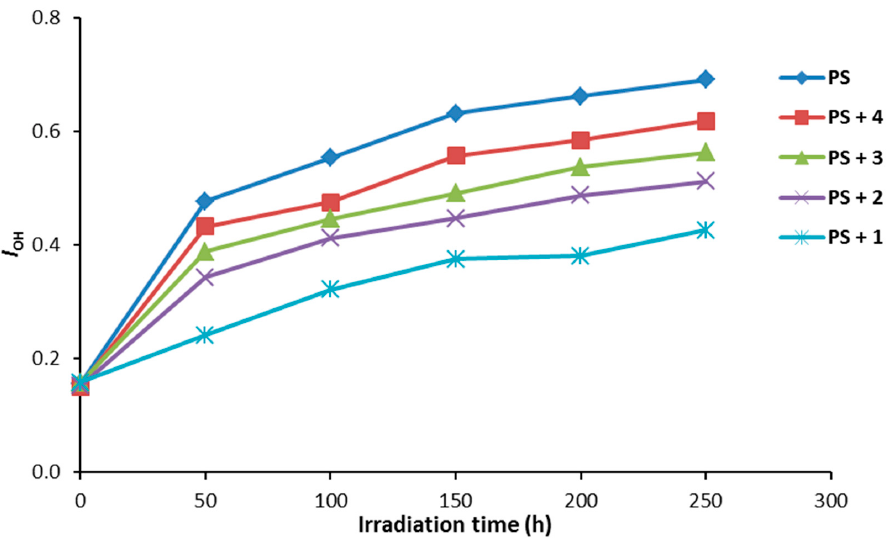
Figure 5. The effect of irradiation on the I OH index for PS films.